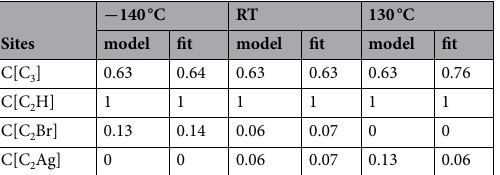
Table 1. Results of the peak-fit analysis performed in Fig. 2: comparison of the ratio between the number of carbon atoms in C[C 3 ], C[C 2 Br] and C[C 2 Ag] sites and the number of carbon atoms in the C [C 2 H] sites. The number of carbon atoms in the C [C 2 H] sites is taken as a reference since, according to the structural models proposed in Fig. 2, it should remain unchanged upon annealing. At 130 °C the fit deviates from the model of debrominated DBBA molecule linked to two Ag atoms. This can be explained by the onset of the formation of covalent C–C bonds. See text for more